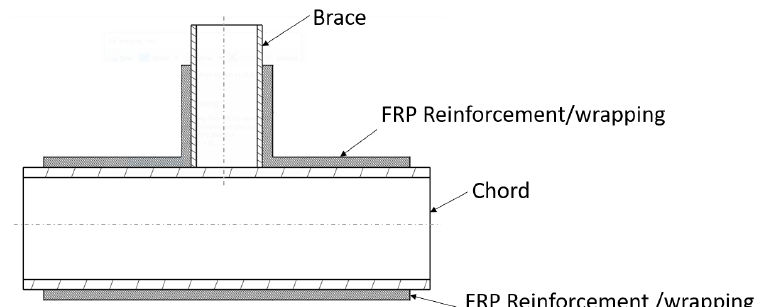
Figure 12. FRP reinforcement of a typical